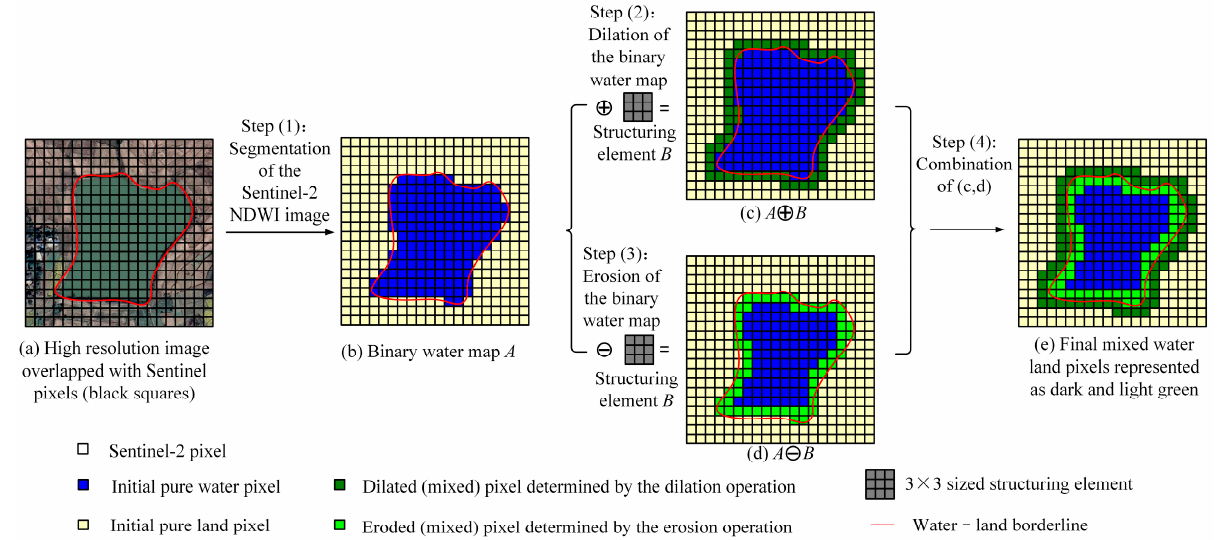
Figure 2. Sketch map illustrating the mixed pixels determined by the morphological dilation and erosion operations. ( a ) The high-spatial-resolution image overlapped with Sentinel-2 pixels. The pond is represented with dark green in ( a ). The Sentinel-2 pixels in the black squares contain many mixed water–land pixels that have red lines (border between water and land) in ( a ). ( b ) The binary water map ( A ) generated by the segmentation of the Sentinel-2 NDWI image. ( c , d ) The maps of A ⊕ 𝐵 and A ⊖ 𝐵 are the results of applying the morphological dilation and erosion operations to A using the 3 × 3 binary structuring element ( B ). The dark green pixels in ( c ) indicate the dilated pixels, and the light green pixels in ( d ) indicate the eroded pixels. The dilated and eroded pixels are combined as the potential mixed water–land pixels in ( e ). The real water–land mixed pixels are those where the water–land borderline (highlighted with the red line) is located within. ( e ) The water–land borderline is located within both the dark green pixels (dilated pixels) and light green pixels (erosion pixels), illustrating that both dilation and erosion operations are required to fully determine the potential mixed water–land pixels. NDWI, normalized difference water index.